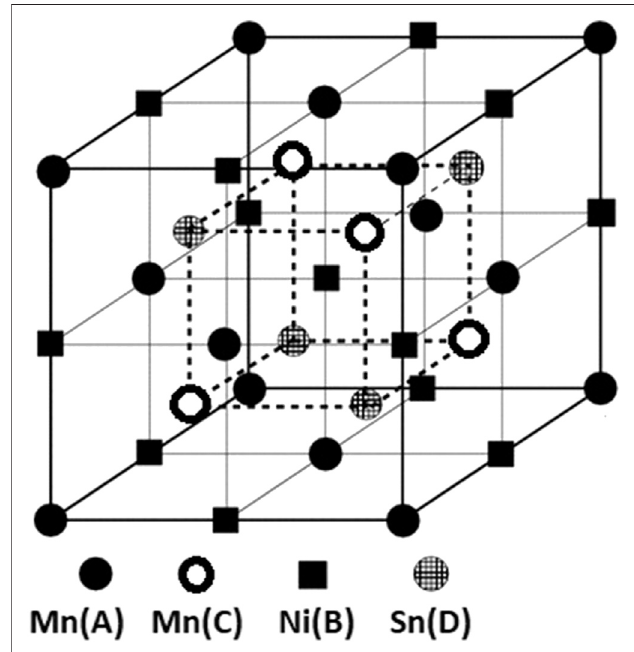
FIGURE 3 | A schematic cubic unit cell comprising of four interpenetrating fcc lattices, along with the expected site occupancies of different